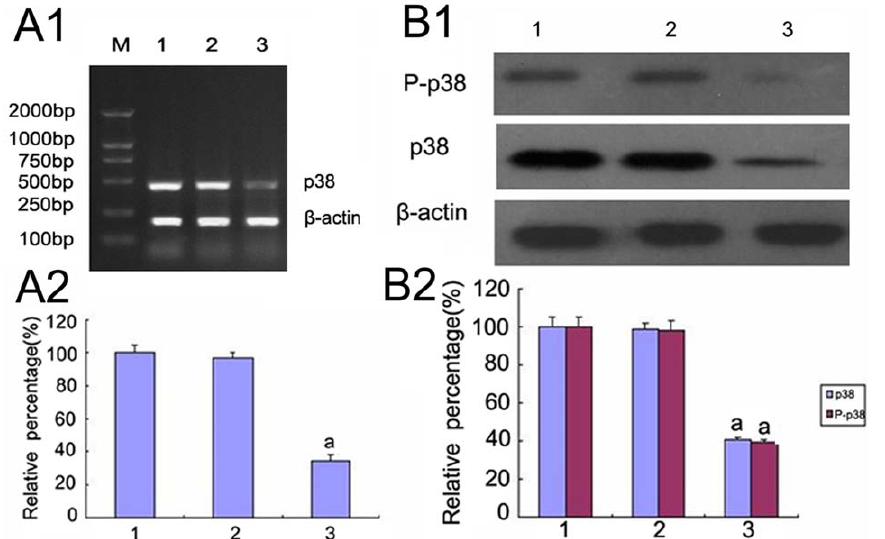
Figure 6. Effect of knockdown of p38MAPK by p38 MAPK siRNA on p38 MAPK expression by Western blot and RT-PCR analysis. (A)P38 MAPK expression were determined by RT-PCR of the HK-2 cells cultured for 72 h in 5.5 mM glucose (lane 1), 5.5 mM glucose + Cont siRNA (lane 2), 5.5 mM glucose + p38 siRNA (lane 3). (B)P38 MAPK expression were determined by Western blot of the HK-2 cells cultured for 72 h in 5.5 mM glucose (lane 1), 5.5 mM glucose + Cont siRNA (lane 2), 5.5 mM glucose + p38 siRNA (lane 3).Values represent the mean 6 SD, a P , 0.05 vs. 5.5 mM glucose.